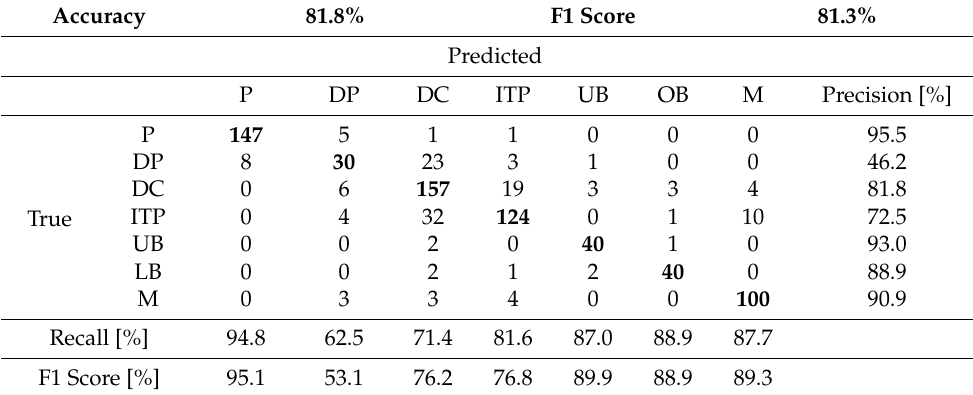
Table 4. Confusion matrix of classification strategy 2 (hierarchical).